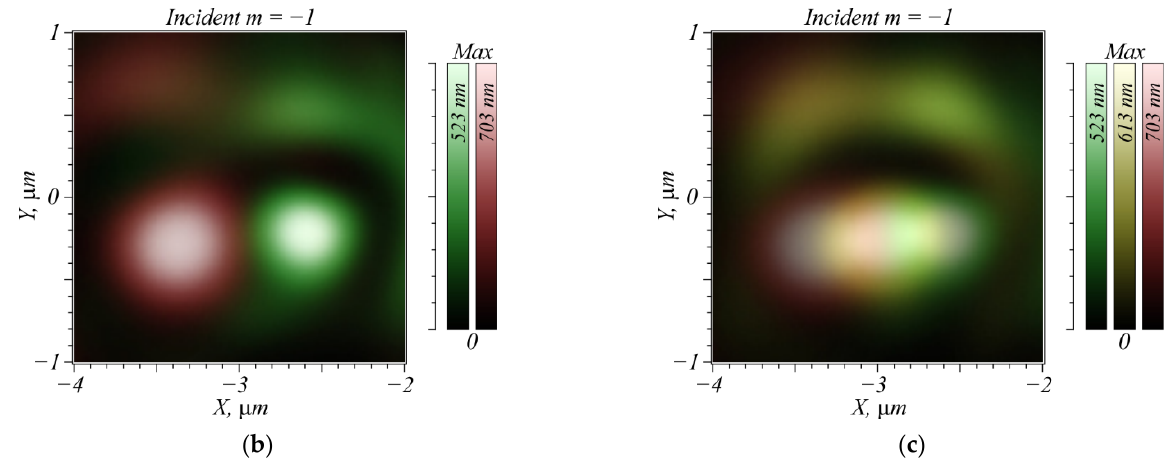
Figure 4. The intensity maxima profiles of a focused vortex with TC m = − 1 for three incident wavelengths λ = 523 nm, 613 nm, and 703 nm ( a ), simultaneous location of two ( b ) and three ( c ) focused vortices in the focal plane, in accordance with their relative intensities.